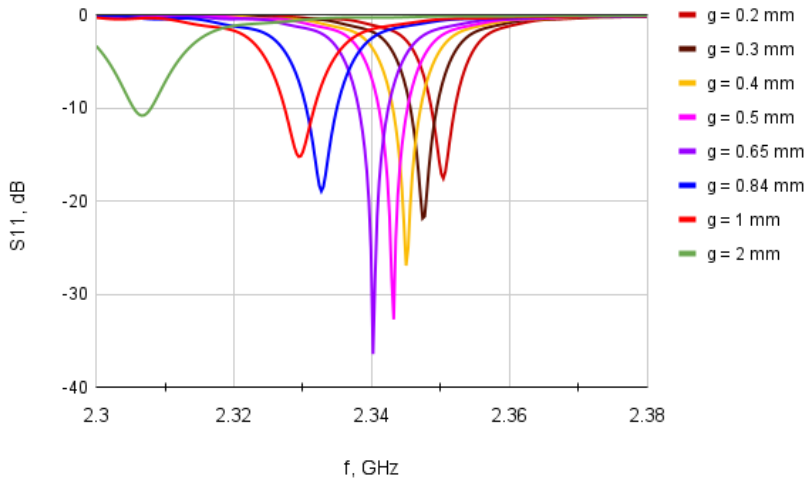
Figure 6. A sweep analysis showing dependence of S 11 versus g .